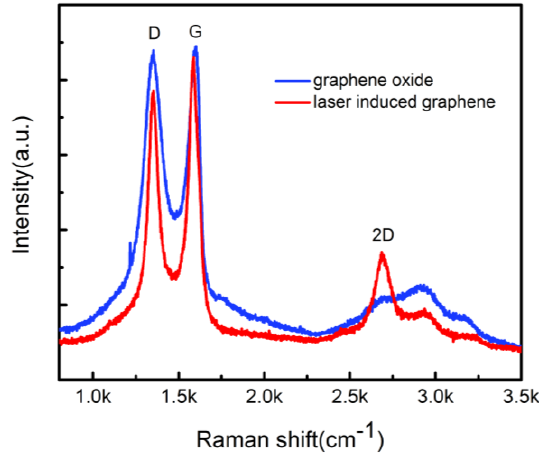
Figure 4. The Raman spectrum of the graphene oxide (blue line) and laser induced graphene (red line)